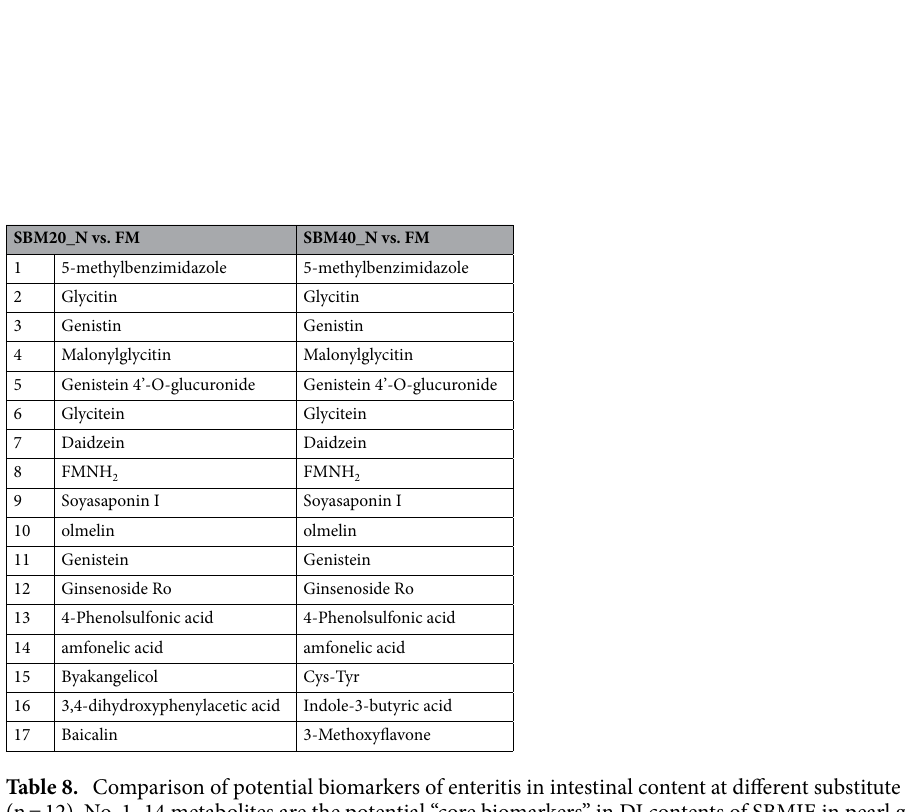
Figure 18. Correlation analysis of the potential biomarkers between FM and SBM20_N groups and FM and SBM40_N groups in positive ( A , C ) and negative ( B , D ) modes (n = 12). Note: The blank part is the significance level of the correlation statistical test P > 0.05, and the color marked part is the significance level P < 0.05. The highest correlation is 1, which is a complete positive correlation (red); the lowest correlation is—1, which is a complete negative correlation (blue). FM_N, fish meal control group; SBM20_N, 20% SBM protein replacement level to FM protein; SBM40_N, 40% SBM protein replacement level to FM protein.